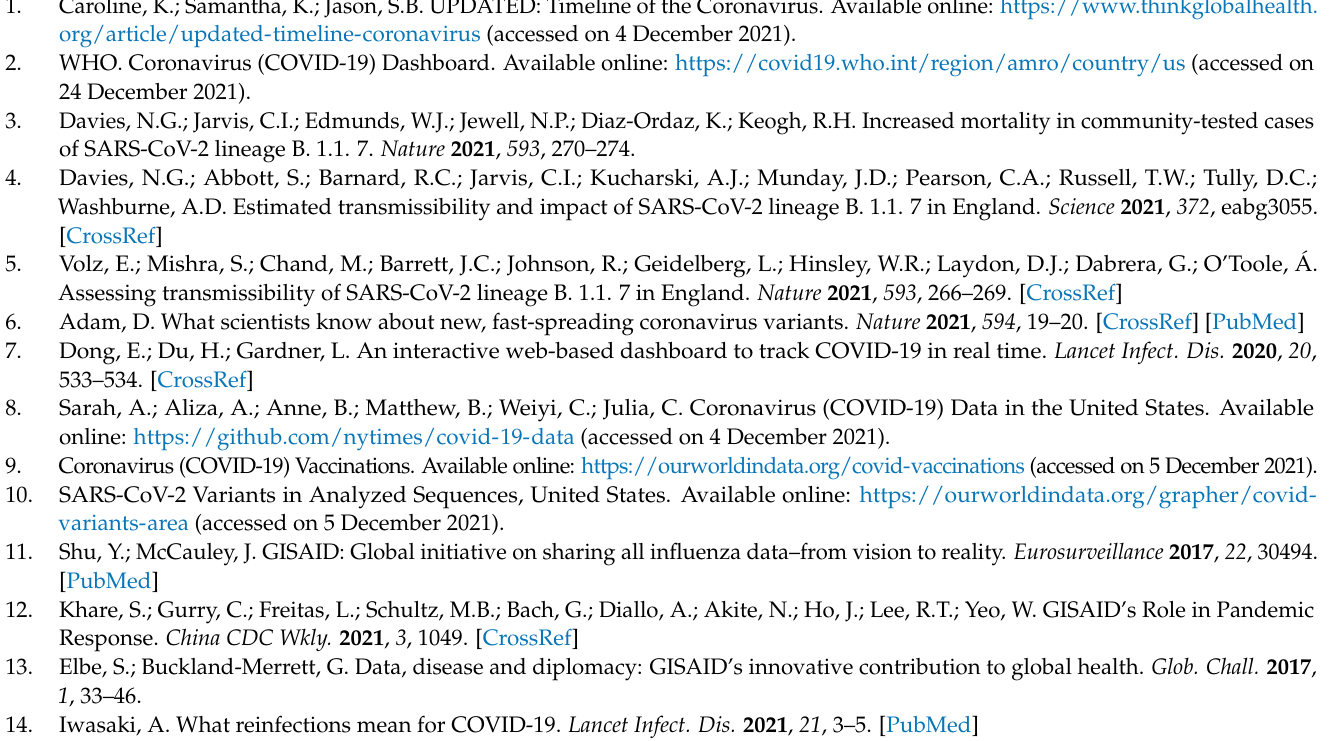
Figure S2: Applying the second approach, the model fit for the other 19 US states. Others are the same as Figure 2; Figure S3: Ratios of estimated total deaths in the two scenarios for the other 38 US states and the District of Columbia fitted under the two approaches; Figure S4: Daily number of cases from SARS-CoV-2 in all 50 US states and the District of Columbia from March 2020 to November 2021; Figure S5: Daily number of deaths from SARS-CoV-2 in all 50 US states and the District of Columbia from March 2020 to November